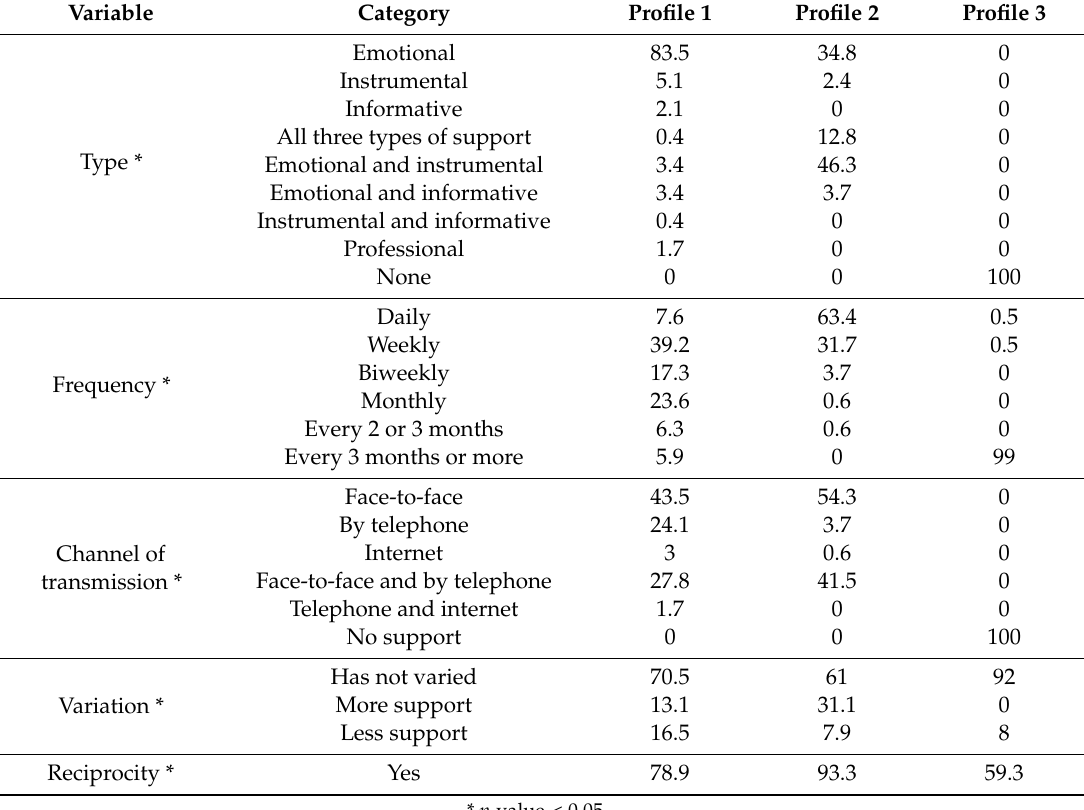
Table 7. Social support variables in the three profiles (%).